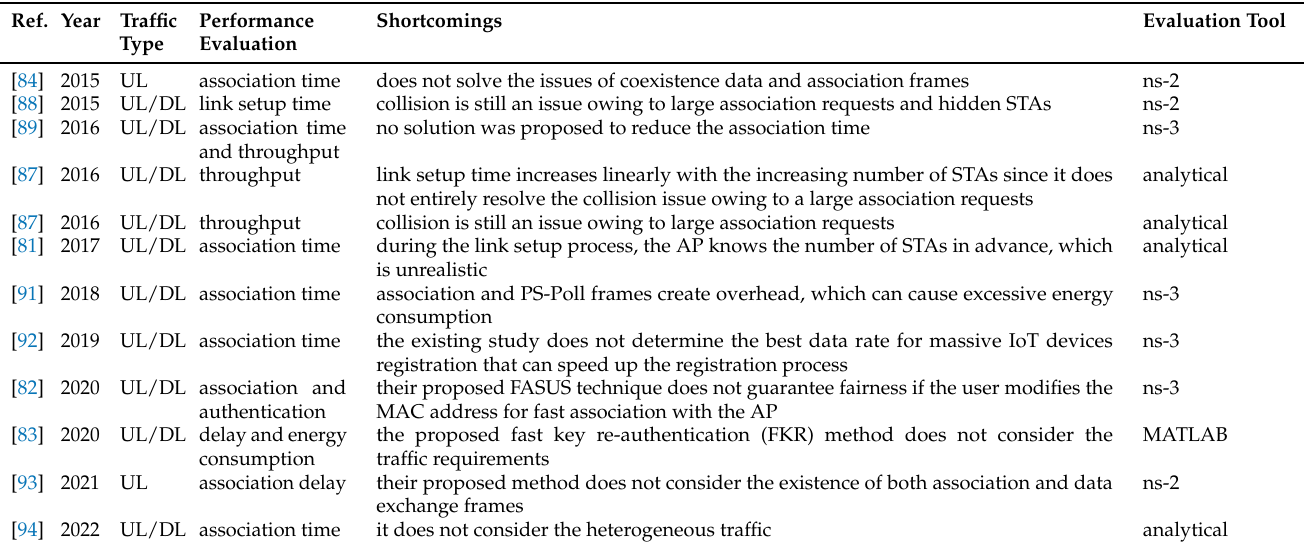
Table 4. Existing solutions on authentication and association along with